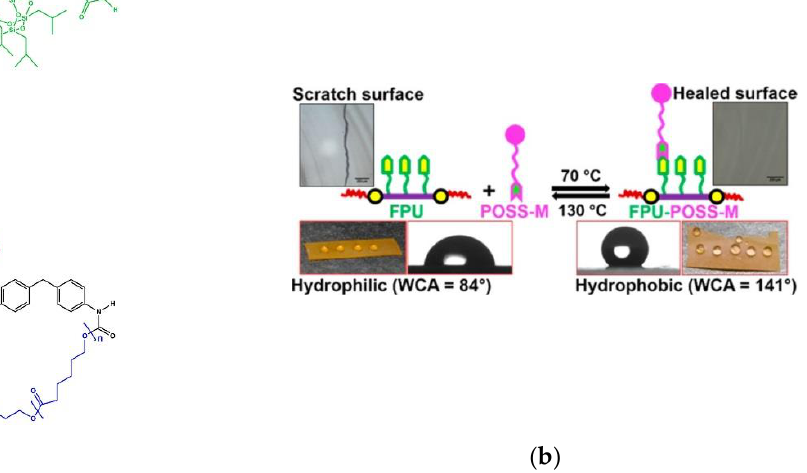
Figure 11. ( a ) Dynamic DA process in FPU-POSS-M and ( b ) changes in physical properties as a result of self-healing. Reprinted with permission from Macromolecules 2018, 51 , 4770–4781. Ref. [74] Copyright (2018) American Chemical Society.